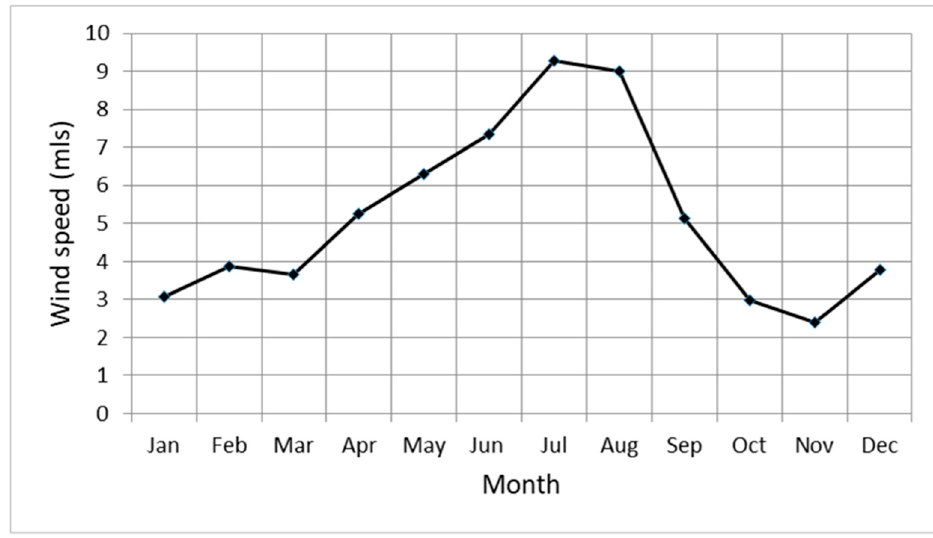
Figure 3. Monthly average wind speed for four years.